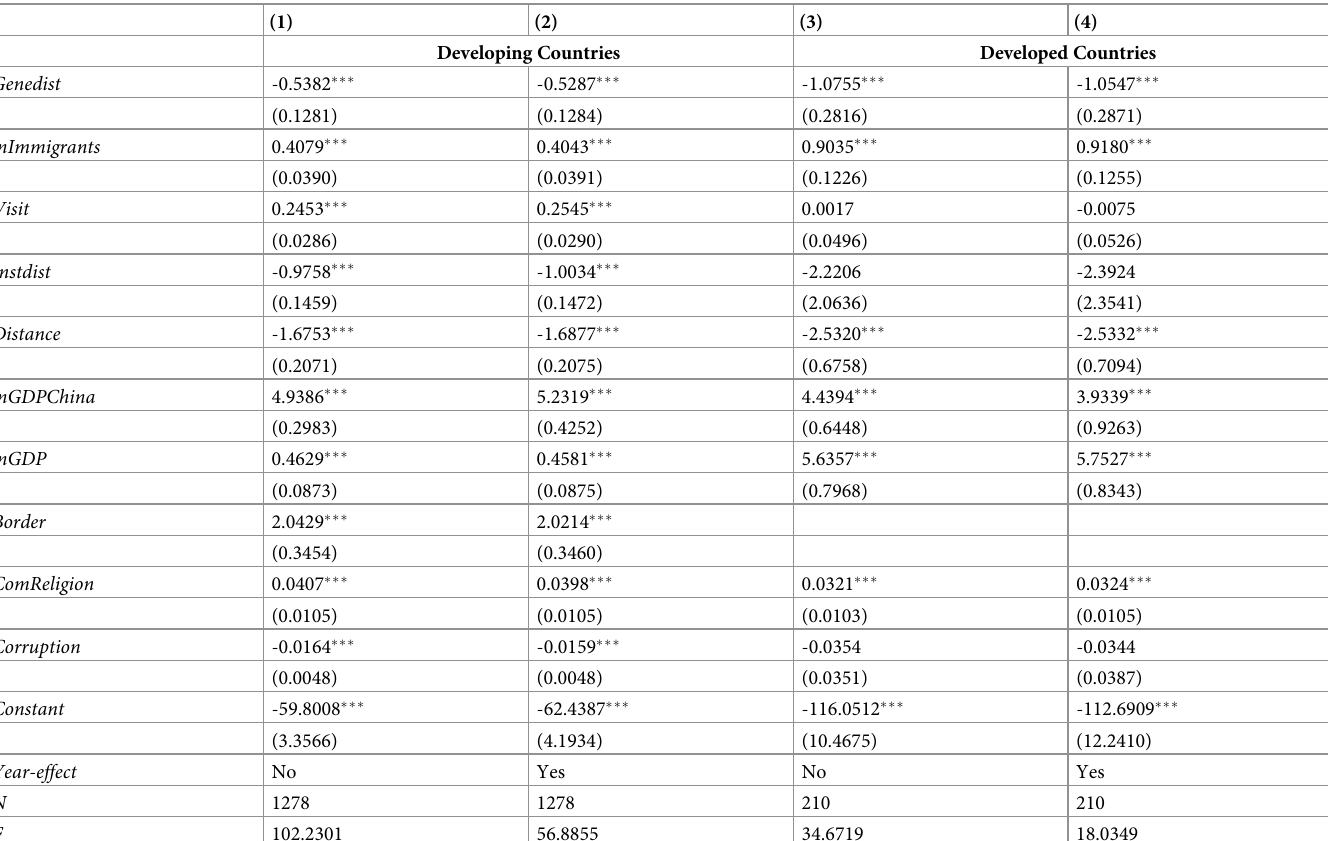
Table 4. The impact of “intimate” relations on China’s OFDI in energy sector: Considering developing and developed